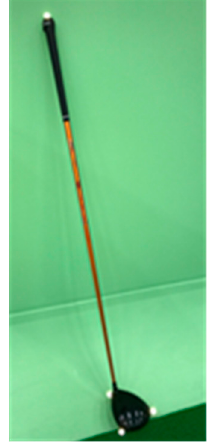
Figure 2. Marker locations on